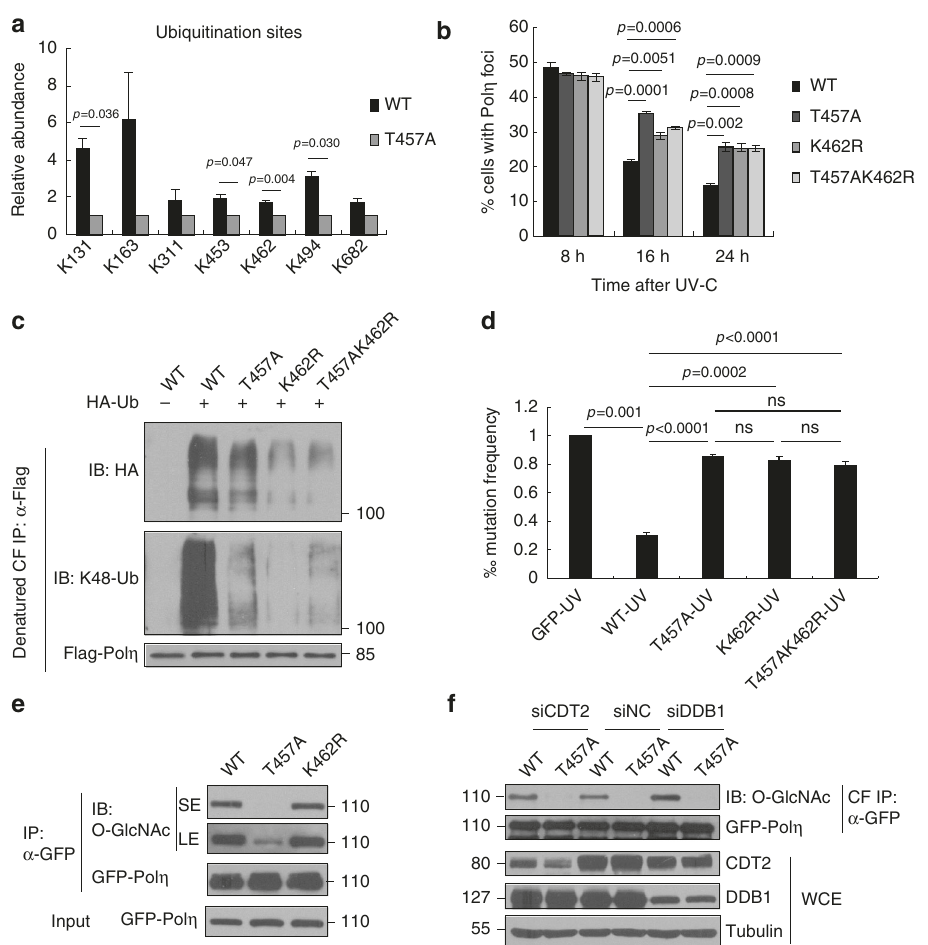
Fig. 5 T457A impairs Pol η polyubiqitination at K462. a 293T cells transfected with Flag empty vector, WT, or T457A Flag-Pol η and HA-Ub were immunoprecipitated with anti-Flag agarose in a denatured condition followed by quantitative MS analysis as described in “ Methods ” section. All ubiquitination sites identi fi ed in WT and T457A Pol η . Error bars: s.e.m. b U2OS cells transfected with WT or mutated (T457A, K462R, and T457AK462R) GFP-Pol η were irradiated by UVC (15 J m − 2 ) and further incubated for 24 h. The proportion of GFP-Pol η -expressing cells with > 30 foci was determined. Data represent means ± SEM from three independent experiments. c 293 T cells were transfected with WT or mutated (T457A, K462R, and T457A/ K462R) Flag-Pol η and HA-Ub. The collected chromatin fractions (CFs) were denatured followed by immunoprecipitation with anti-Flag agarose. The immunoprecipitates were immunoblotted with anti-HA, anti-K48-Ubiquitin, and anti-Flag antibodies. d Mutation frequency in damaged (400 J m − 2 UVC) supF plasmid was determined. Data represent means ± SEM from three independent experiments. ns not signi fi cant. e WT, T457A, or K462R GFP-Pol η were transfected into 293T cells. The cell lysates were immunoprecipitated with GFP-Trap A, followed by immunoblotting with anti-O-GlcNAc and anti-GFP antibodies. “ SE ” and “ LE ” represent short and long exposure, respectively. f WT or T457A GFP-Pol η were transfected into siDDB1-, siCDT2-, or siNC-treated 293T cells. The chromatin fractions were immunoprecipitated with GFP-Trap A and analyzed via western blotting with anti-O-GlcNAc and anti-GFP